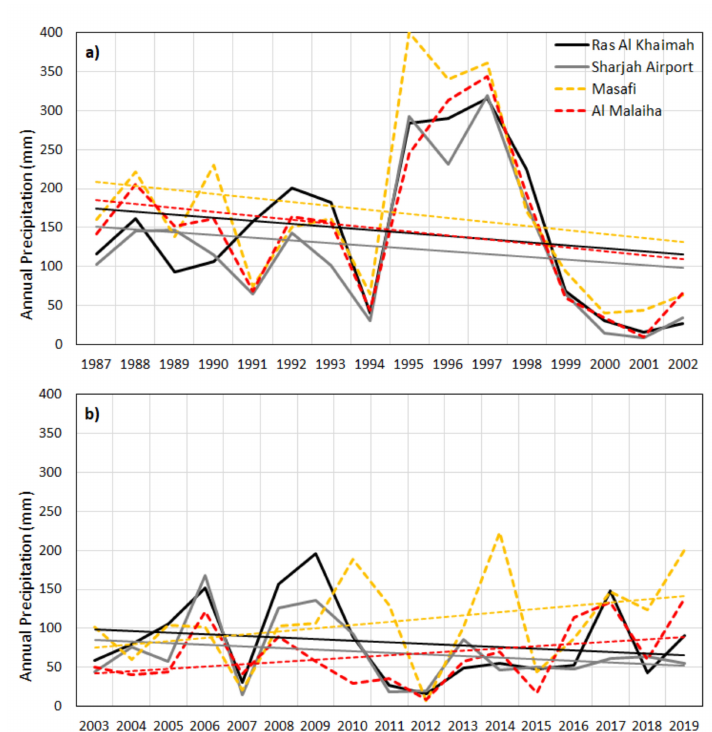
Figure 2. Time series and linear trends for selected rain gauges within the control (Ras Al Khaimah and Shrajah) and target (Masafi and Al Malaiha) areas ( a ) before (1987–2002) and ( b ) after (2003–2019) the initiation of cloud seeding operations.